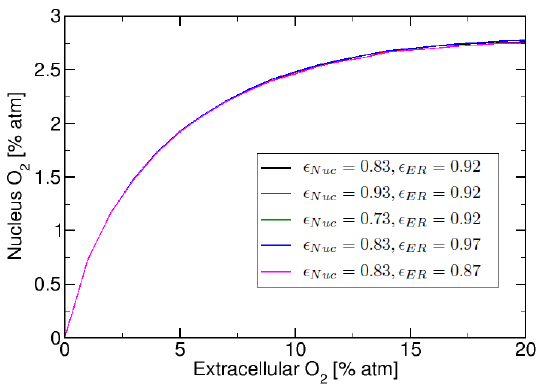
Figure 5. Nuclear oxygen vs. extracellular oxygen for 10 total regions (corresponding to cytosol, nucleus, 3 ER regions and 5 membranes) with varying combinations of (cid:101)